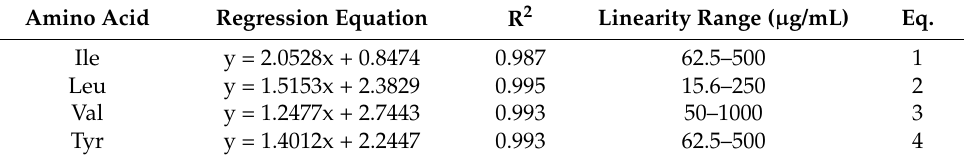
Table 4. Calibration data for Ile, Leu, Val and Tyr, with the developed IP-RP-HPLC/ELSD method. Amino Acid Regression